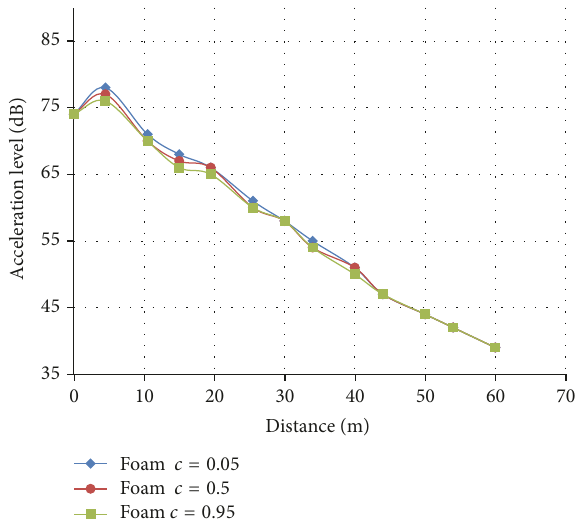
Figure 20: Comparison of acceleration level among cases 1 , 2 , and 3 in Scheme 4